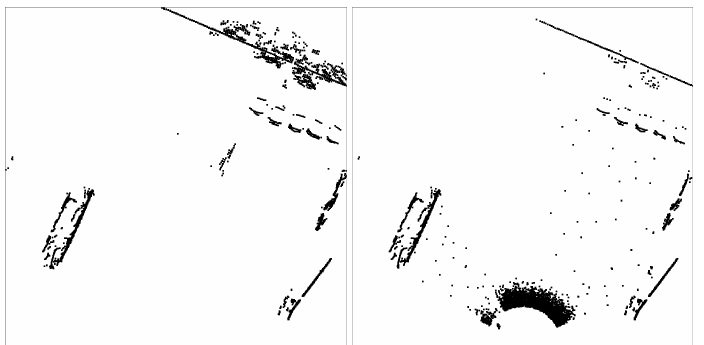
Figure 6. An example of the affects of the weather simulation injecting strong artificial fog on an accumulation of several LiDAR frames, where the laser scanner is positioned at the bottom of the image. ( Left ): the original points captured by the scanner. ( Right ): the affect of the simulations on the data, producing a large band of points close to the sensor, but also produces changes to the appearance of distant objects, reducing the number of usable points for classification. There are also some phantom intermediate detections present. Not visible are the changes to the LiDAR intensity data, which are also